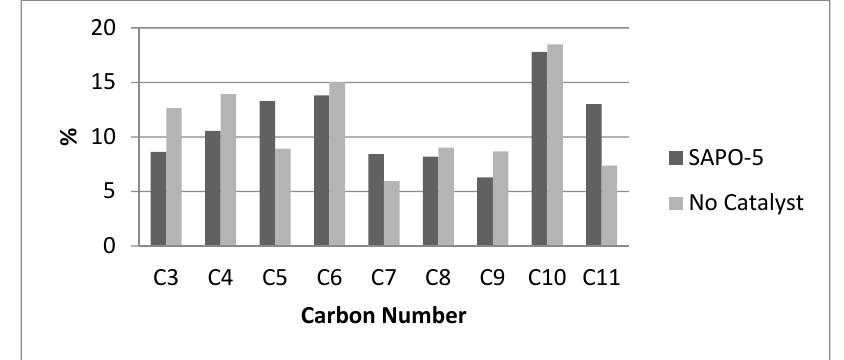
Figure 9. Normalized distribution of the α -olefins obtained after pyrolysis of lauric acid at 650 °C :( ) SAPO-5 catalyst and ( ) no catalyst.